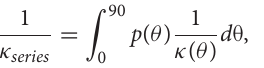
FIGURE 9 | Representatives of (A) Transient temperature curve of hcp iron obtained at 18.5 GPa and 300K (Run #2) and (B) SEM image of a cross section of the recovered sample prepared by the FIB apparatus. The transient temperature curve was fitted by Equation (2) (yellow curve). In this case, we set n = 5. The obtained fitting parameters are shown in (A) . Note that this SEM image has been acquired from an oblique direction to sample stage, and thus the apparent thickness shown in this figure is different from the actual sample